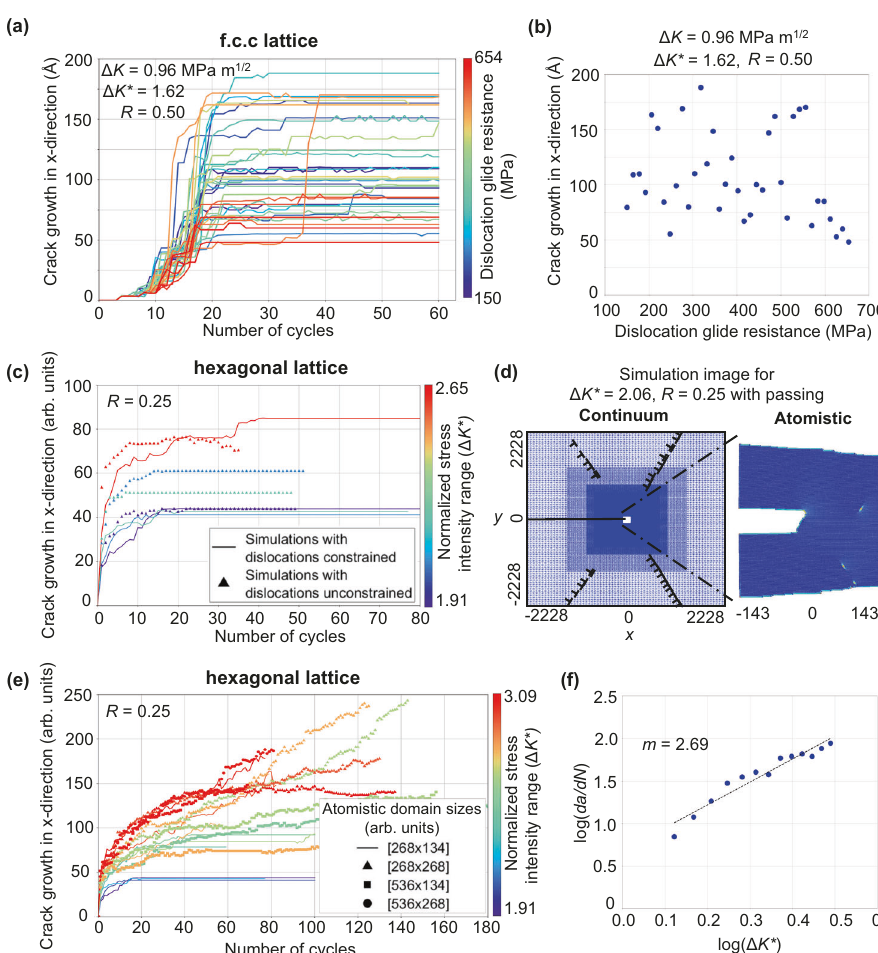
Fig. 1 Crack advance as a function of loading cycle from three sets of simulations. a ( − 1 1 3) crack in an fcc aluminum lattice. Each curve represents a distinct dislocation glide resistance in the continuum domain. The majority of cases show crack growth over the fi rst 20 cycles and crack arrest shortly after. b The location of the arrested cracks are shown as a function of glide resistance, showing no correlation between the two variables. c A ductile 2D hexagonal lattice at various loading amplitudes. Again, cracks arrest after an initial transient period. Cases are shown both with and without dislocations being constrained to the atomistic domain to establish that restricting dislocation motion does not in fl uence behavior (see Supplementary Fig. 1). d The dislocation distribution and the crack tip con fi guration for an arrested crack, with edge dislocations having nucleated from the crack tip along the two slip planes 60° from the horizontal axis as shown. e A ductile 2D hexagonal lattice with dislocations constrained in the atomistic domain at larger cycle counts and higher loading amplitudes. Dimension of the atomistic window size used in each simulation is labeled in square brackets as speci fi ed in the legend. Crack arrest was observed in all but a few cases at the higher loading amplitudes. f Plot of log(d a /d N ) vs. log( Δ K ) from the fi rst 10 cycles showing the data conforms to Paris' law, consistent with previous atomistic simulations that analyzed crack growth in the initial transient period. m represents the Paris law exponent, i.e. log – log slope. For the 2D hexagonal lattice simulations, distances are normalized by the magnitude of the Burgers vector, b , and the range of = K nuc the normalized stress intensity factor that is used to characterize the loading amplitude, Δ K (cid:1) ¼ Δ K I I